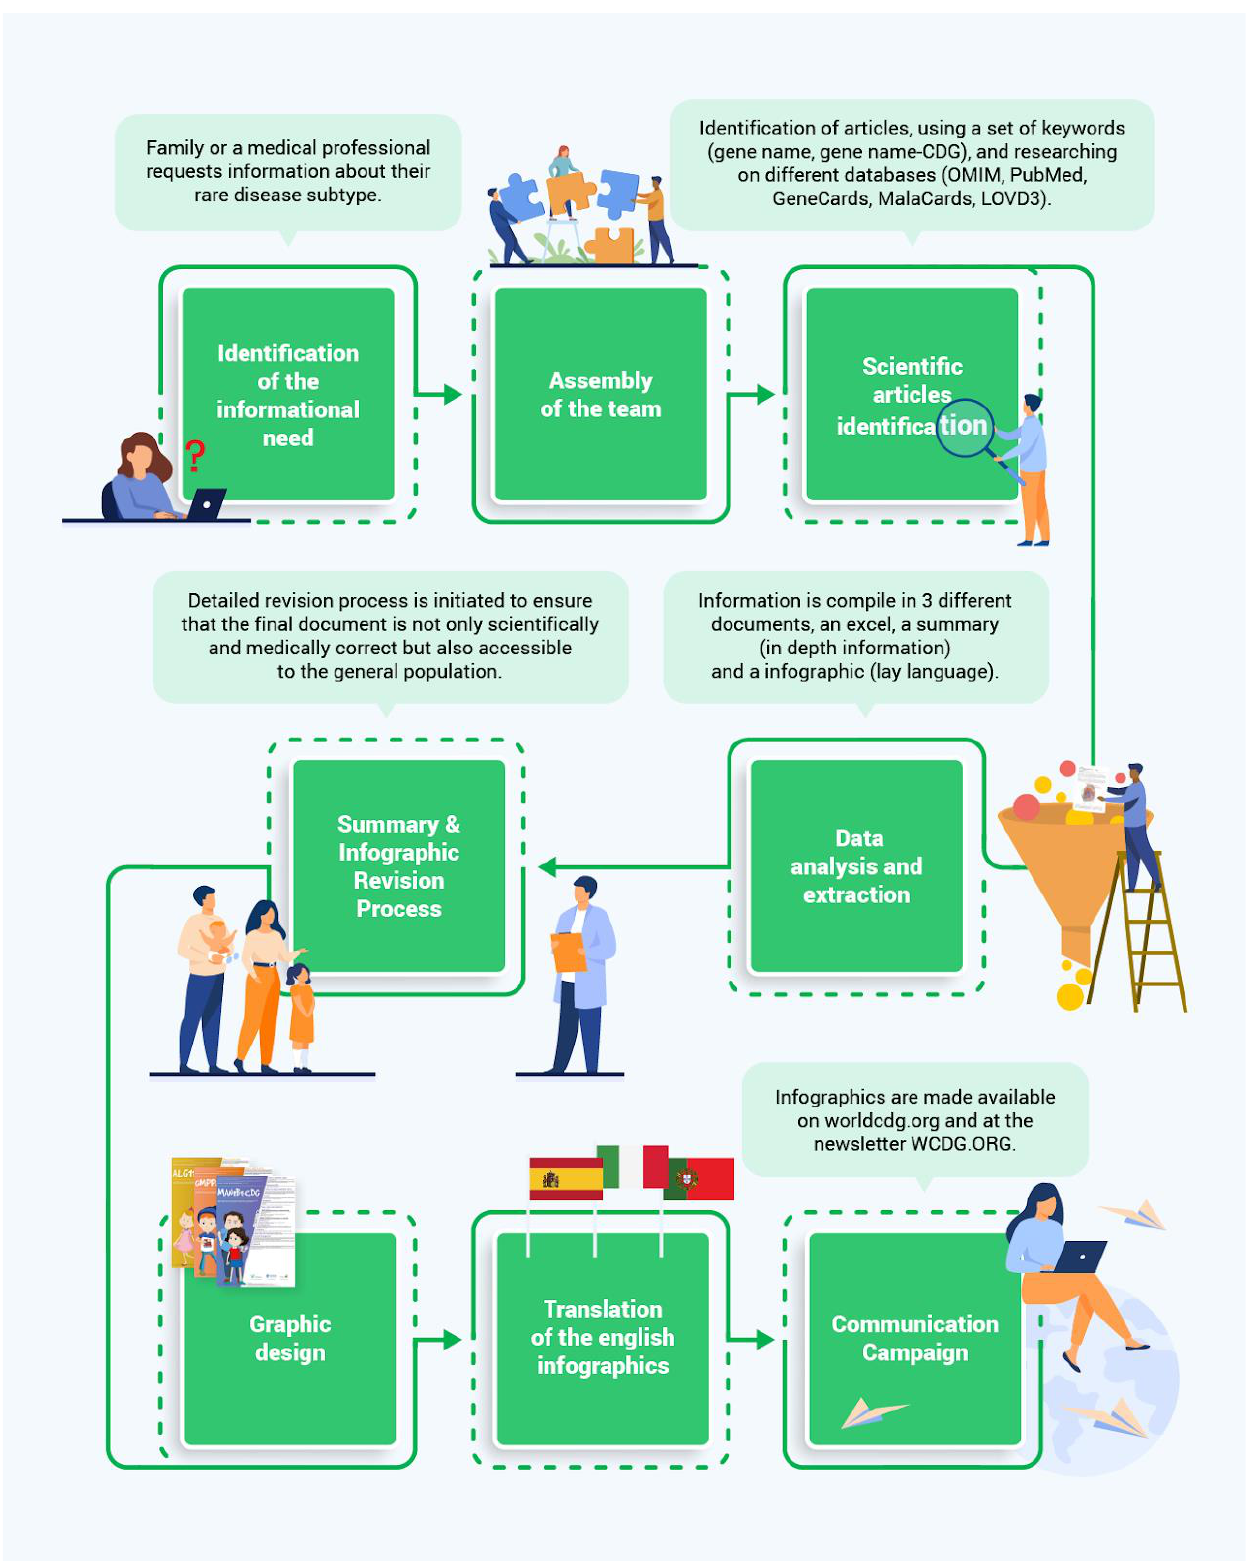
Figure 2. Community-based framework developed to guide the creation of PEMs.